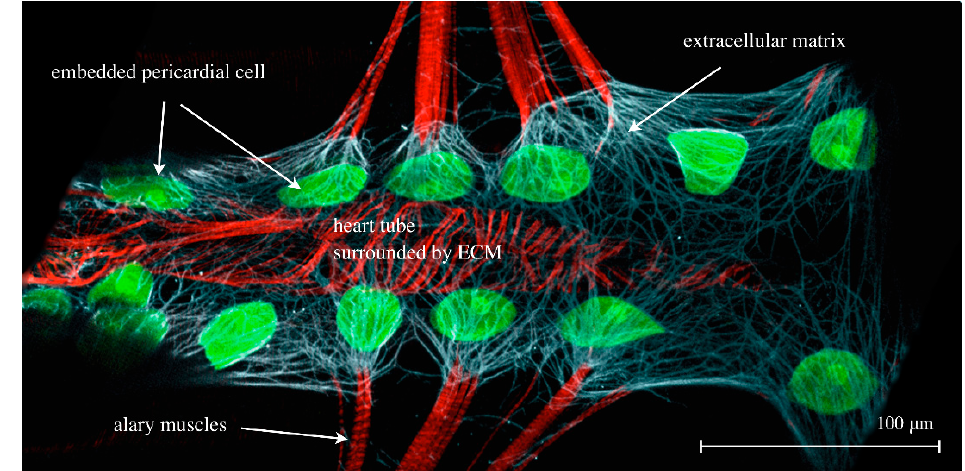
Figure 7. The cardiac ECM of a dissected third instar larva expressing hand -GFP (green channel) and stained for Phalloidin (F-actin, muscles, red channel) and anti-Pericardin, a cardiac-specific ECM constituent (white channel).